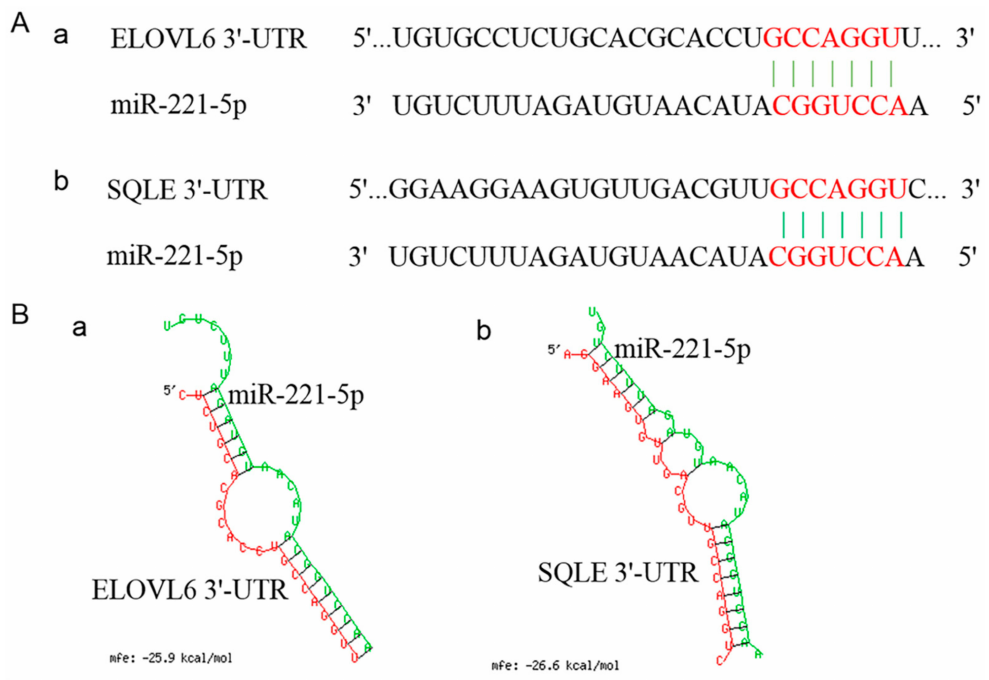
Figure 5. Sequencing information of ELOVL6 ’s and SQLE ’s 3 (cid:48) untranslated regions (3 (cid:48) UTR) binding to the gga-miR-221-5p seed region and the prediction of its free energy. ( A ) Sequencing information of ELOVL6 ’s and SQLE ’s 3 (cid:48) UTR binding to the gga-miR-221-5p seed region. ( B ) Free energy information of ELOVL6 ’s and SQLE ’s 3 (cid:48) UTR binding to gga-miR-221-5p. 2.4. Verification of the Interaction Relationship between gga-miR-221-5p and Potential Target